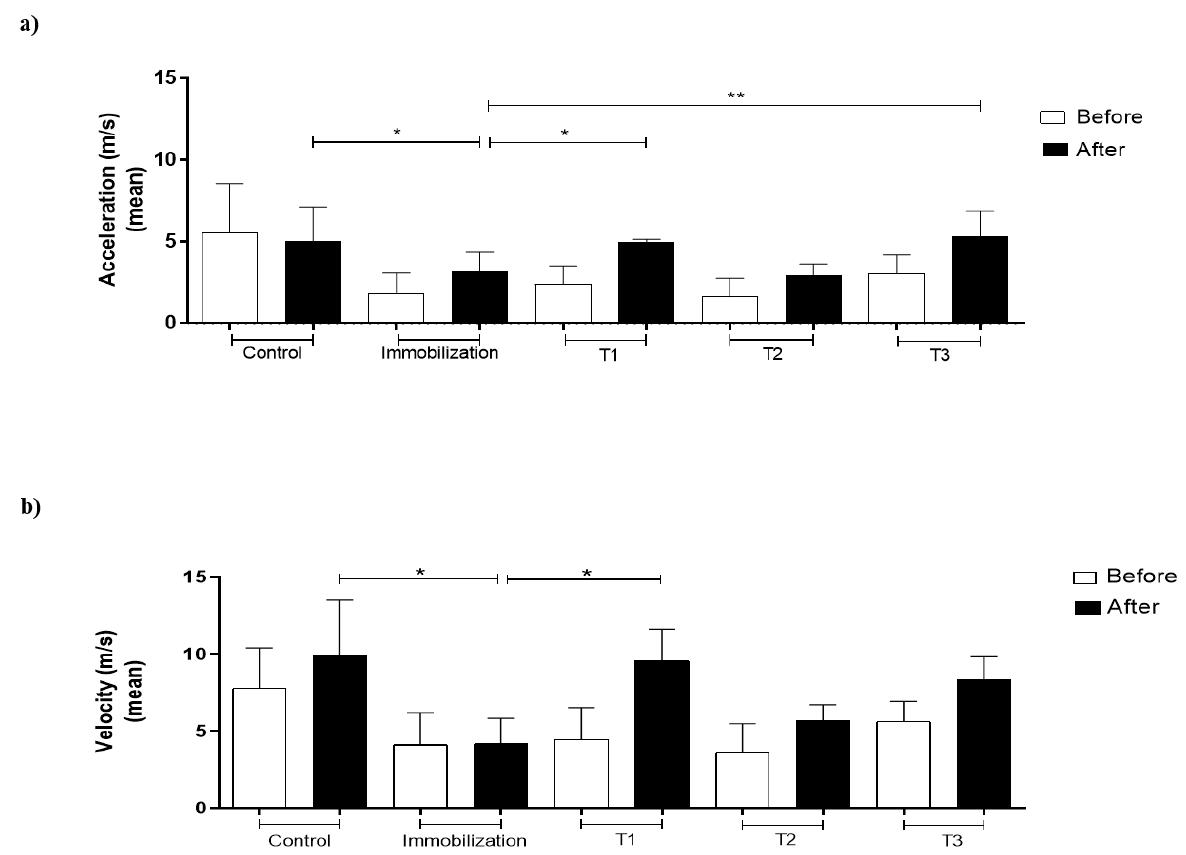
Figure 5. Analysis of data obtained with the CVMob of experimental animals carried out between and within groups in the period before and after 30 days of using EOAz. a) averages of gait acceleration of rats; b) average gait speed of rats. Where T1 (treatment 1), T2 (treatment 2) and T3 (treatment 3). ANOVA One-Way test with Tukey post- test, with * p <0.05; ** p